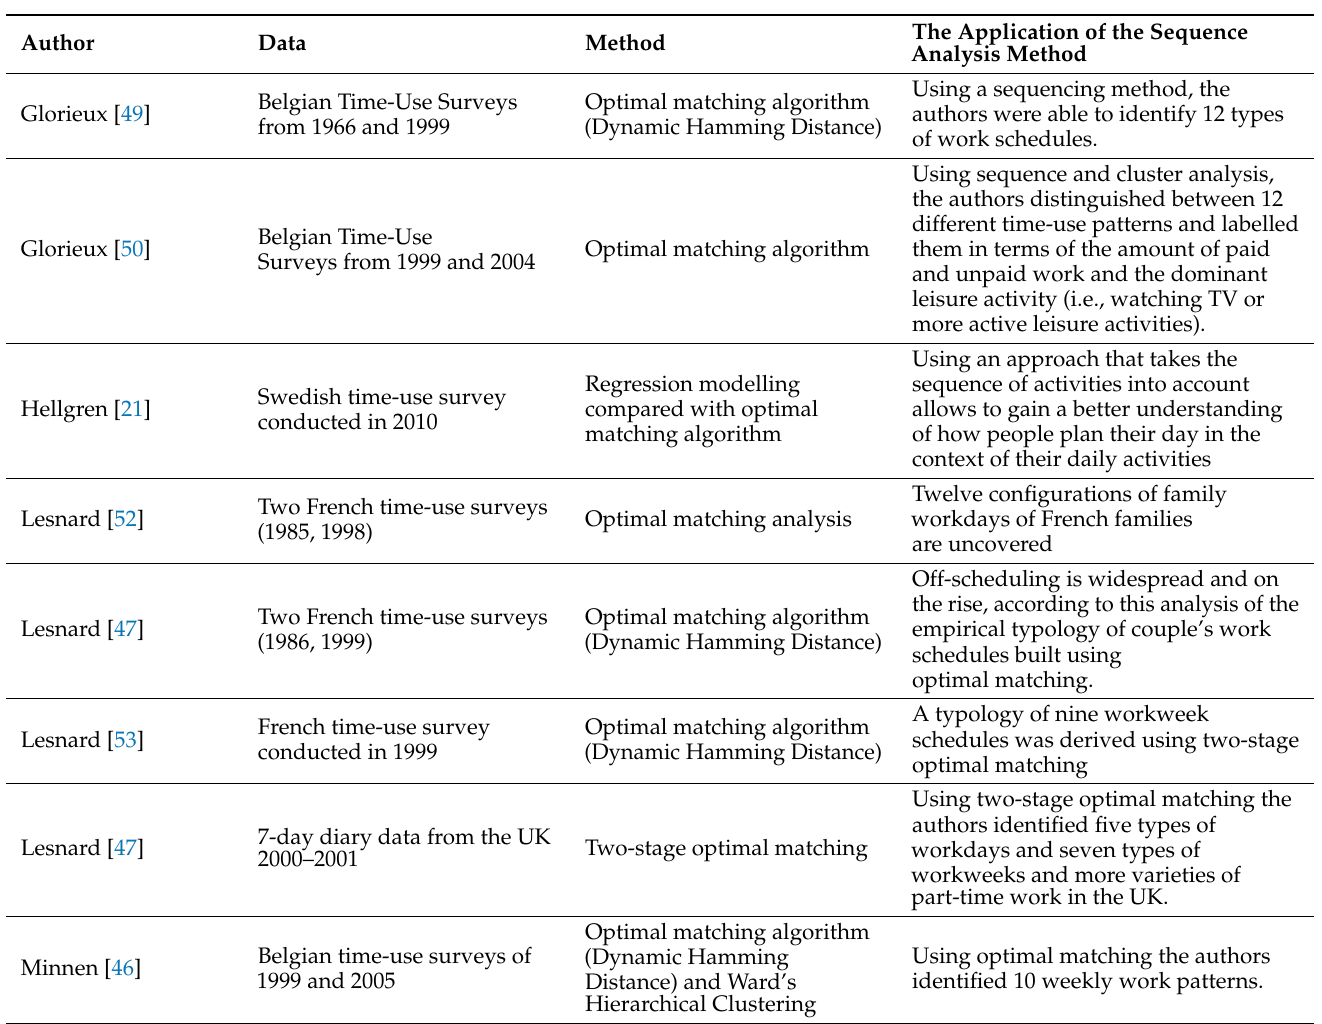
Table A2. Types of work schedules on working